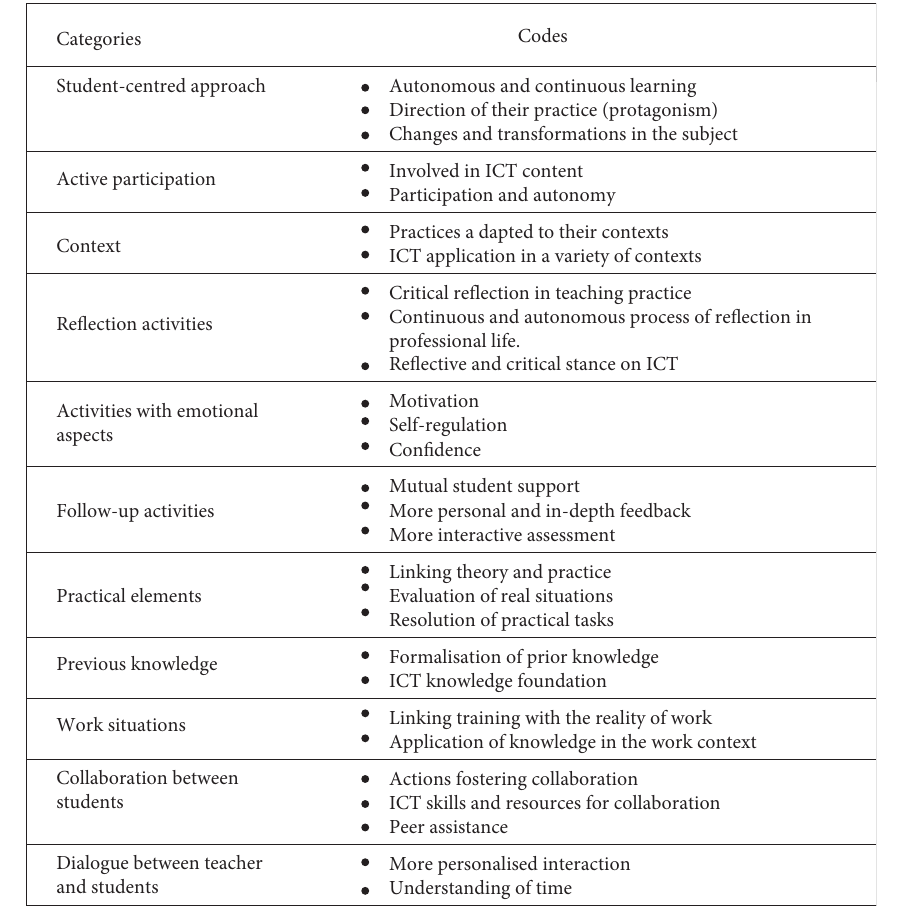
Figure 2: Codebook produced using the Nvivo